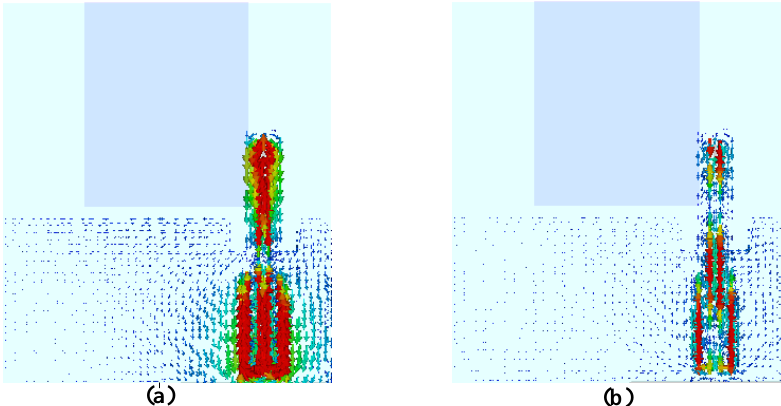
Figure 5. Simulated reflection coefficients of the last three reference antennas.